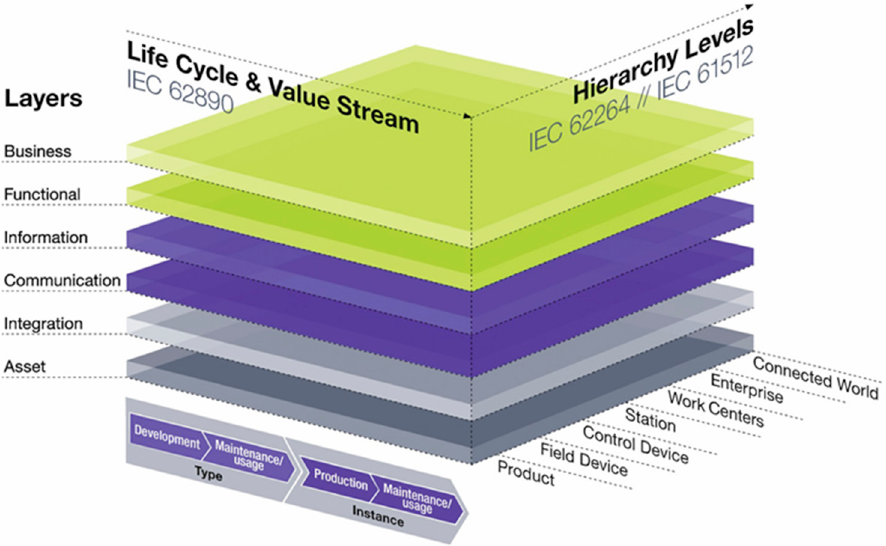
Figure 2. The RAMI4.0 framework [15]; this figure © Plattform Industrie 4.0 & ZVEI— Zentralverband Elektrotechnik—und Elektronik-industrie e.V. Elektrotechnik—und Elektronik-industrie